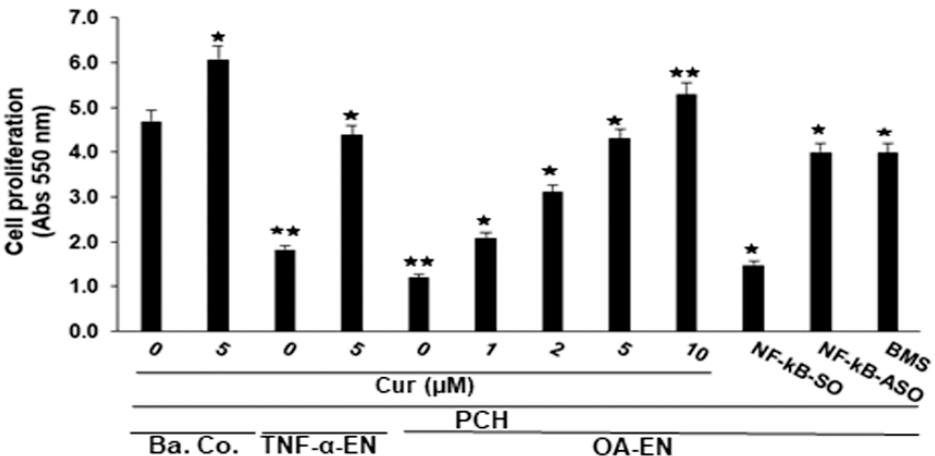
Figure 2. Influence of curcumin, NF-kB-ASO or BMS-345541 on chondrocyte viability and prolif- eration in the osteoarthritic environment. Chondrocytes in alginate cultures by themselves (Ba. Co.) or in co-culture with fibroblasts and TNF- α (TNF- α -EN) or in co-culture with fibroblasts and T-lymphocytes (OA-EN) were either not treated or treated with different dosages of curcumin (Cur) or with NF-kB-SO/NF-kB-ASO for 14 days, and cell proliferation was monitored with MTT reagents as outlined in Materials and Methods. A minimum of three replicates of each assembly was used. p < 0.05 ( ★ ) and p < 0.01 ( ★★ ) denote a meaningful comparison with the basal control sample as refer- ence.